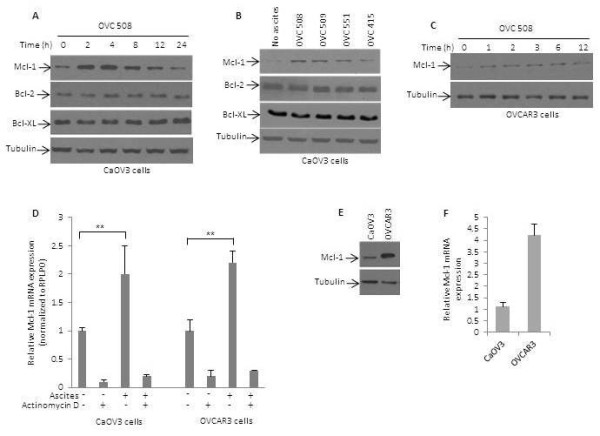
OC ascites stimulate Mcl-1 protein and mRNA levels. (A) Time course of Mcl-1 protein expression in CaOV3 cells following addition of 10% OVC508 ascites to the cell culture media. Cells were incubated with complete media for 24 h before the addition of ascites. Immunoblots were probed with anti-Mcl-1, anti-Bcl-2, anti-Bcl-XL and anti-tubulin (as a loading control). (B) Immunoblot analysis of Mcl-1, Bcl-2, Bcl-XL and tubulin expression in CaOV3 cells incubated with different OC ascites (10%). Lysates were obtained 2 h following the addition of ascites. (C) Time course of Mcl-1 expression in OVCAR3 cells following addition of 10% OVC508 ascites. (D) Real-time PCR analysis of Mcl-1 transcript levels in the presence or absence of OVC508 ascites (10%) and actinomycin D. Results were standardized using primers of the housekeeping gene RPLPO. Results are expressed as fold change relative to basal levels observed in cells incubated in the absence of ascites. (E) Immunoblot analysis of basal levels of Mcl-1 protein in CaOV3 and OVCAR3 cells. (F) Quantitative real-time PCR of Mcl-1 mRNA expression levels. Expression data were normalized to internal RPLPO RNA expression. Data represents the mean of two experiments ± SEM. ** indicates P < 0.001.